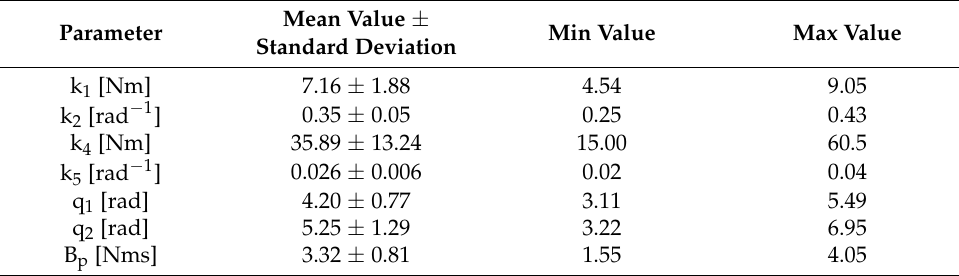
Table 2. Parameters of Hill’s model and passive joint structure model for the elbow joint.